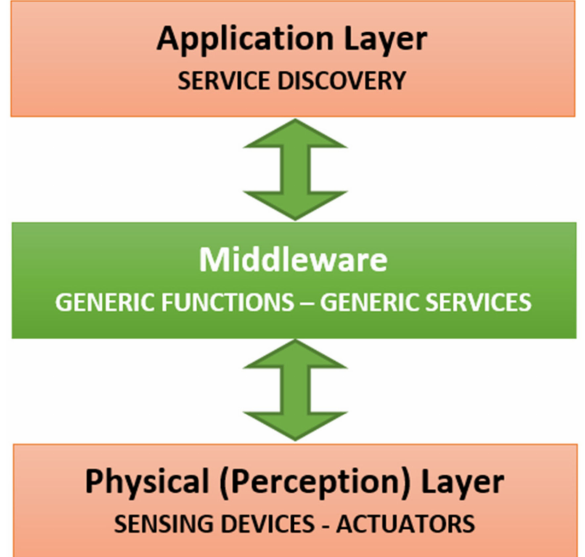
Figure 1. Basic layered IoT architecture